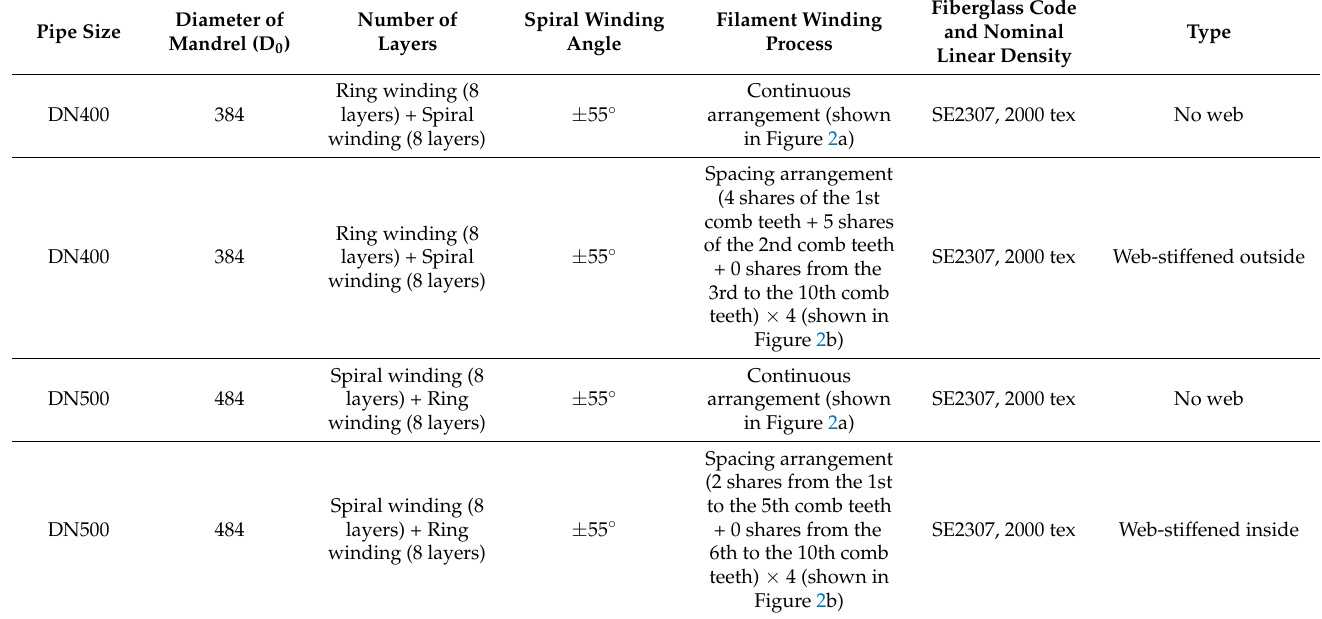
Table 2. Fabrication details of each part of the tested pipe specimens.